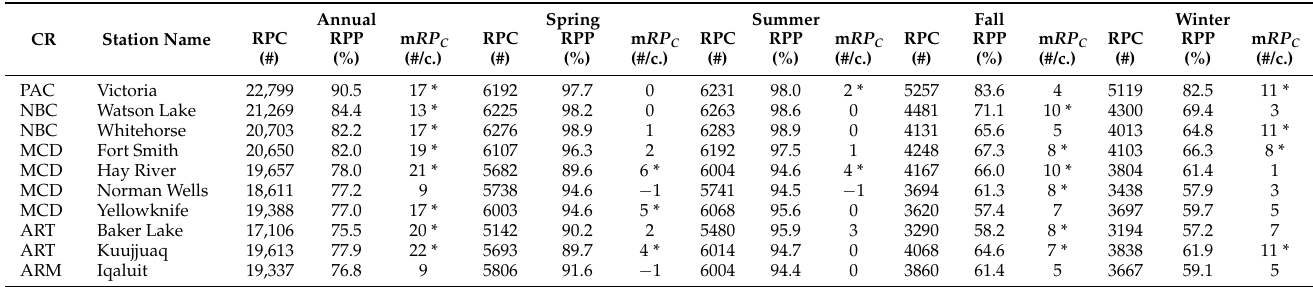
Table 3. Advective population counts, advective population participation, and advective population slope of counts reported per century (#/c.) “m” represents “slope”. APC—Advective Popula- tion Count, APP—Advective Population Participation, and m AP c —Slope of Advective Population Count. “CR” represents “climate region”. ATL—Atlantic Canada, GRL—Great Lakes/St. Lawrence Lowlands, NEF—Northeastern Forest, NWF—Northwestern Forest, PRA—Prairies,